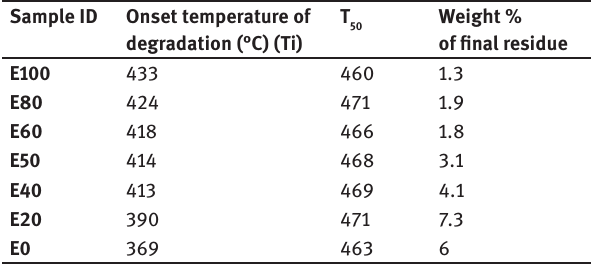
Table 4: TGA results of pristine EMA, NBR and their various blend ratios.